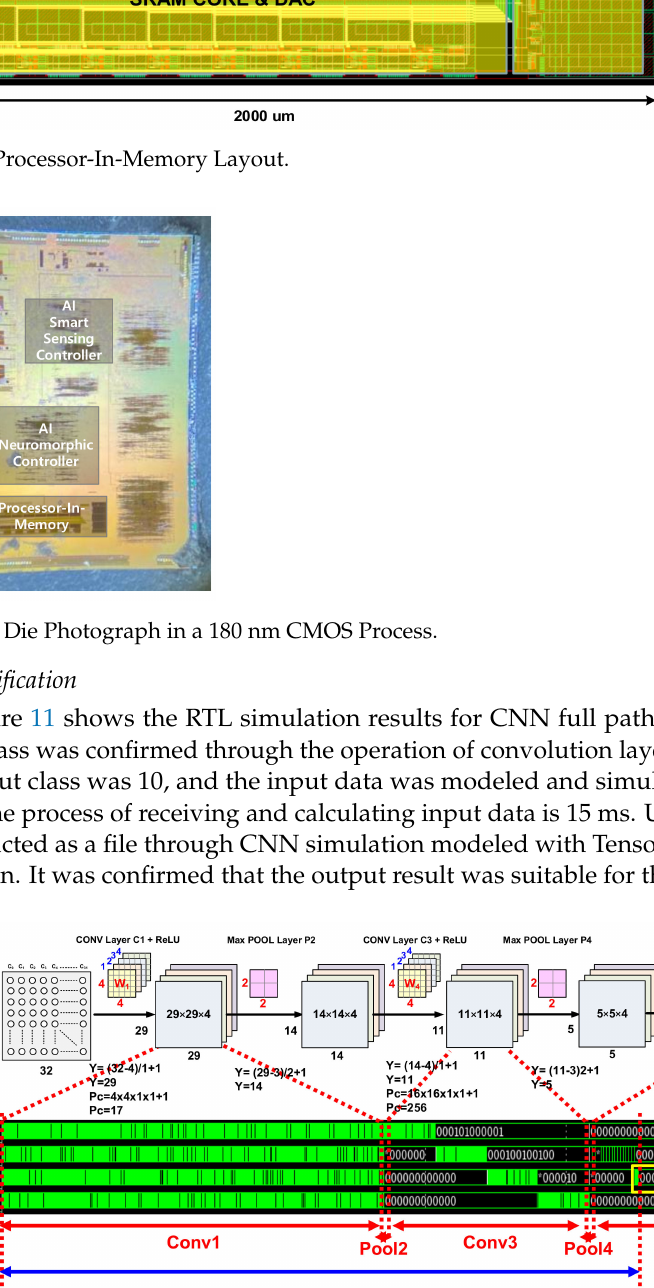
Figure 11. The simulation result of CNN